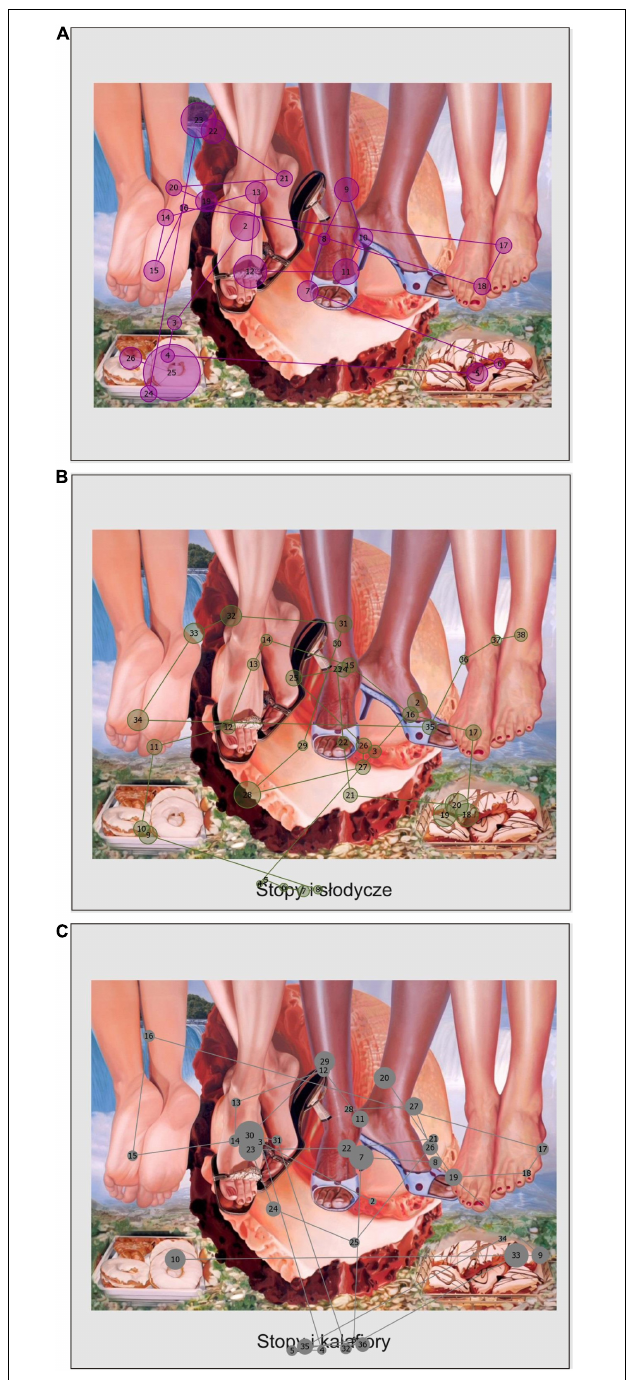
FIGURE 1 | Examples of scanpaths from selected participants for a painting with semantic violations in three conditions. (A) Untitled, (B) consistent title (English translation: Feet and sweets), (C) inconsistent title (English translation: Feet and cauliflowers). The circles represent fixations, solid lines represent saccades, and the numbers correspond to indexes of fixations. The size of circles depicts relative fixation duration. Painting by Koons (2000), oil on canvas, 299.7 × 431.8 cm. Solomon R. Guggenheim Museum, New York. Commissioned by Deutsche Bank AG in consultation with the Solomon R. Guggenheim Foundation for the Deutsche Guggenheim,